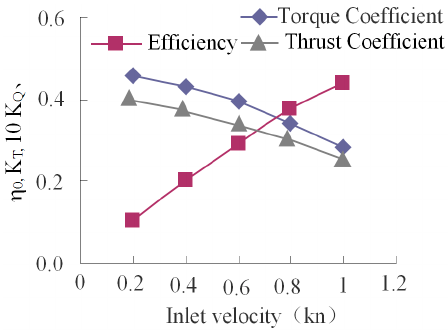
Figure 5. The propeller efficiency curve at 1500 rpm.